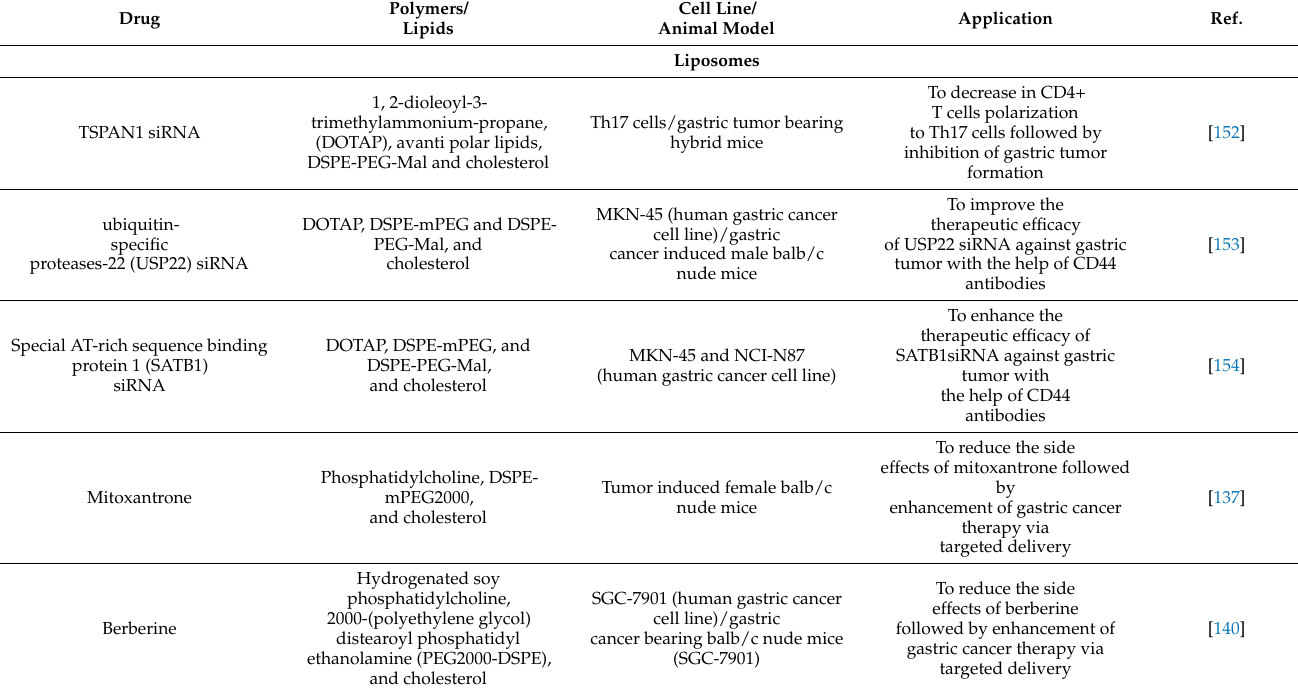
Table 2. List of liposomes/micelles, anticancer drugs, polymers/lipids used, cell lines used, and application of liposomes/micelles for the treatment of stomach cancer as novel drug-delivery systems. Drug Polymers/